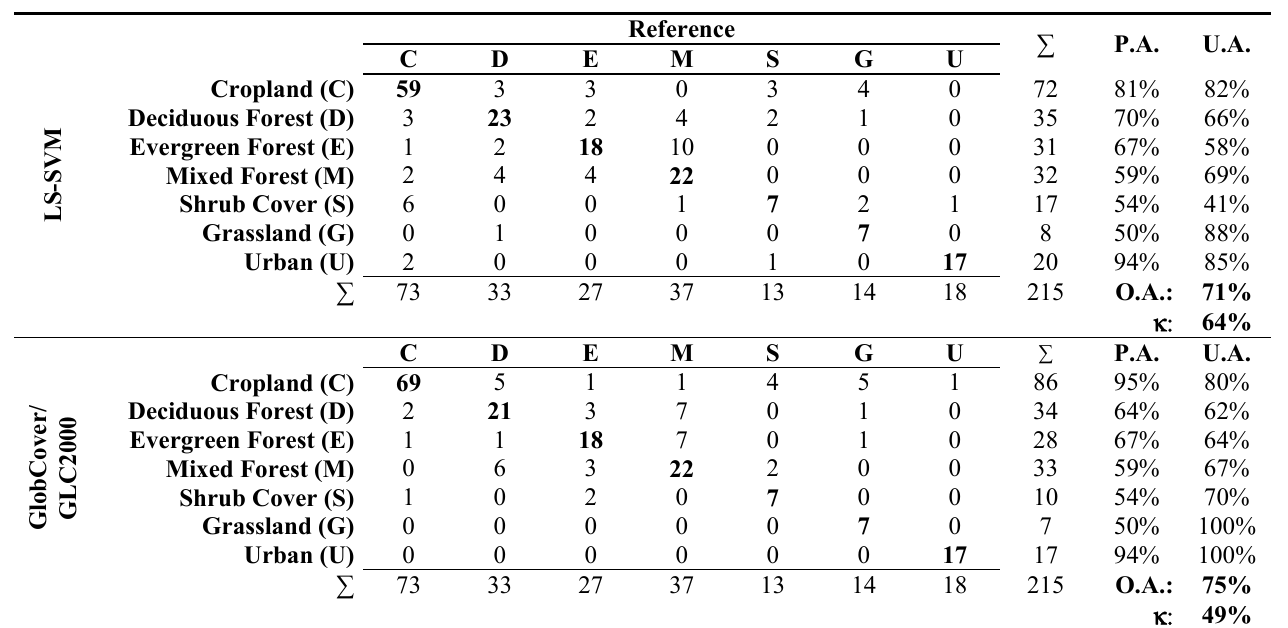
Table 5. Error matrices and statistical measures for LS-SVM and GlobCover/GLC2000 for the agreement data points (n = 215). agr